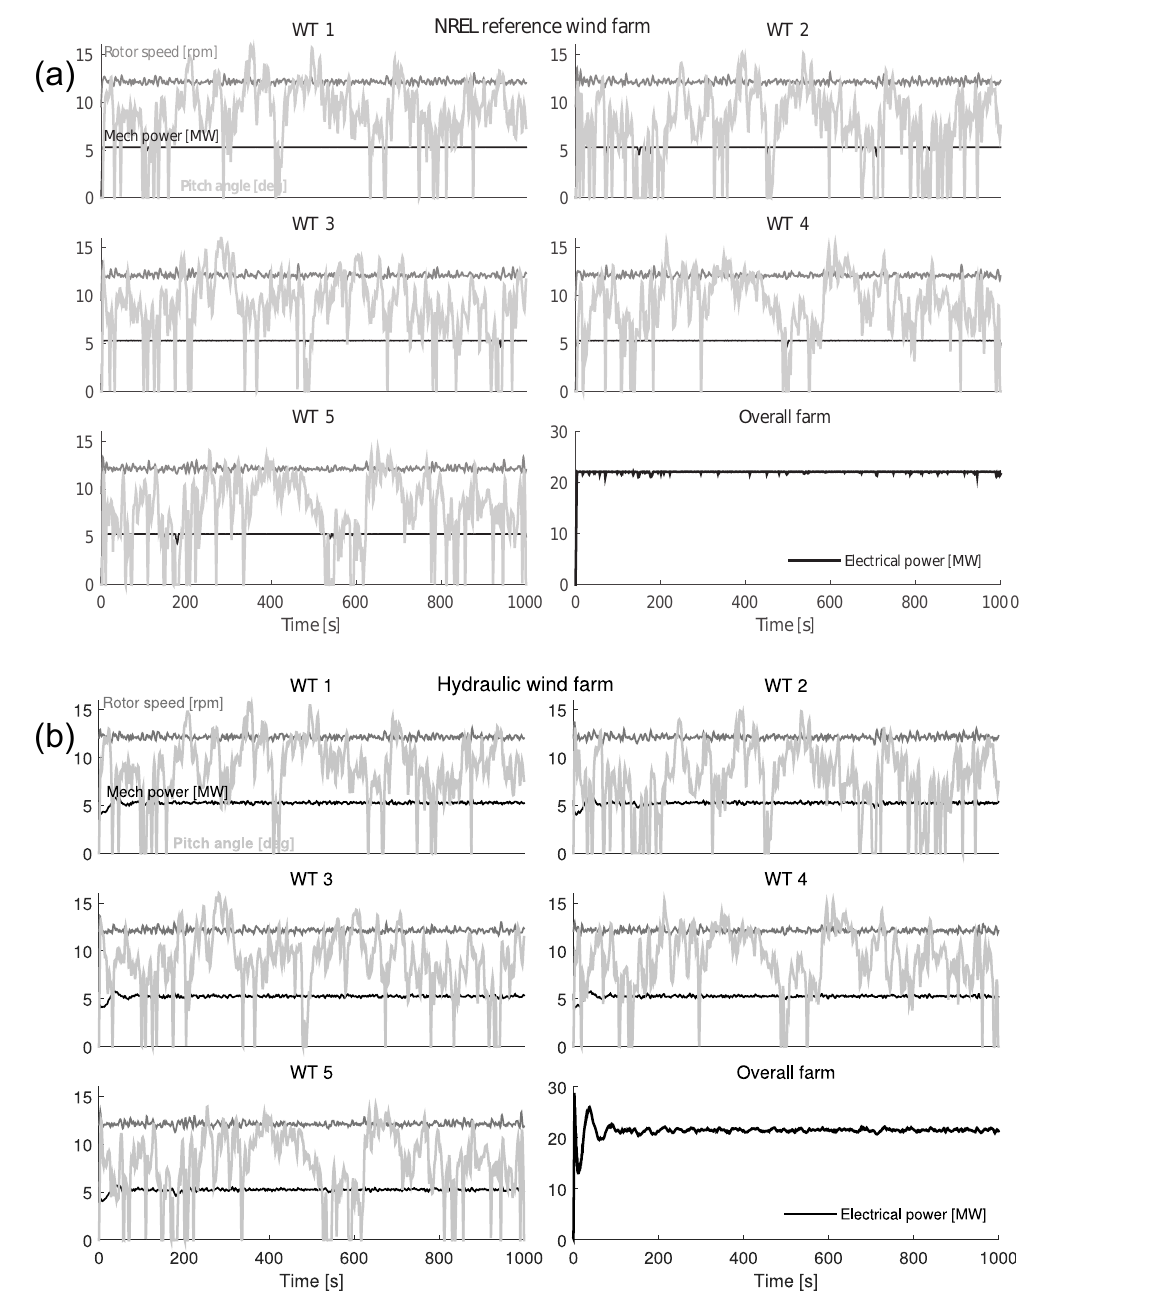
Figure 13. Time domain results for a wind farm comprising of five turbines subject to a wind field with a mean speed of 15ms − 1 and 12% turbulence intensity. (a) Reference wind farm, above rated conditions. (b) Hydraulic wind farm, above rated